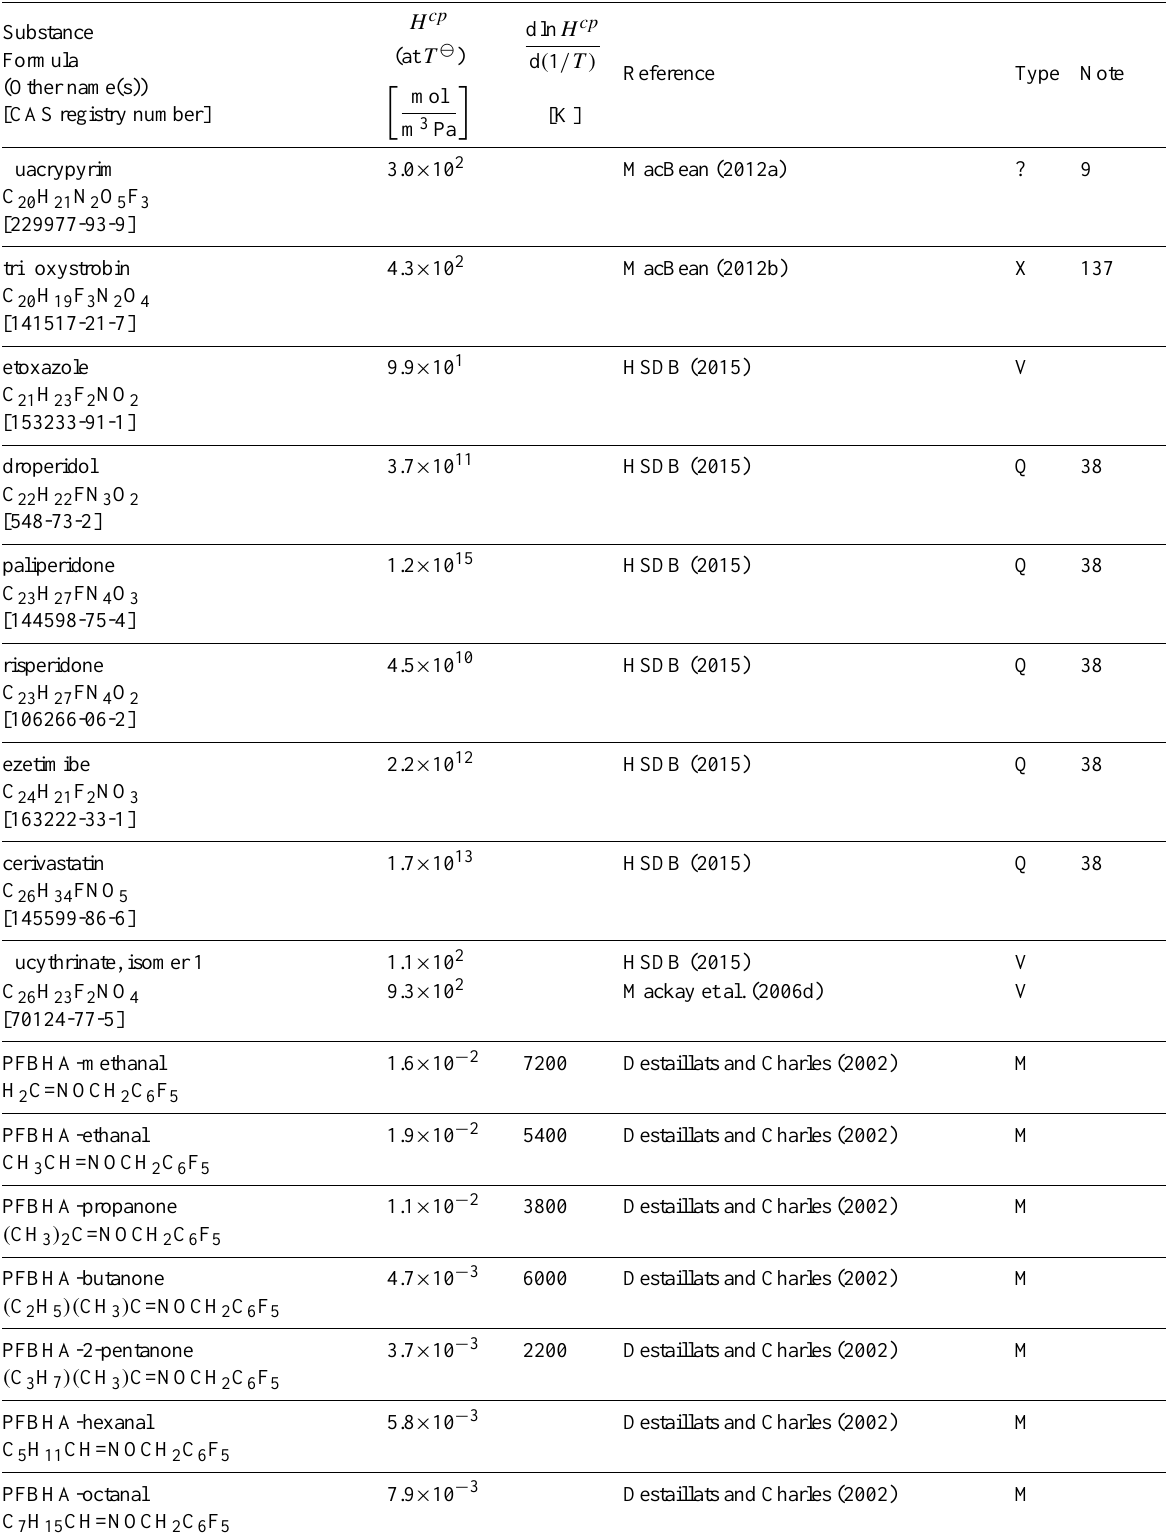
Table 6: Henry’s law constants for water as solvent